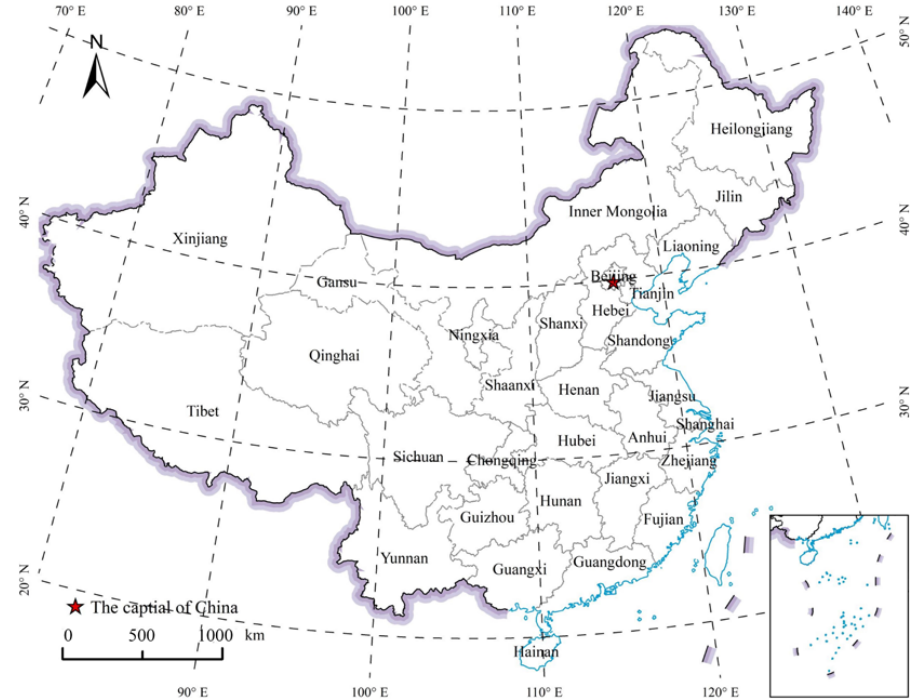
Figure 3. Map of the study